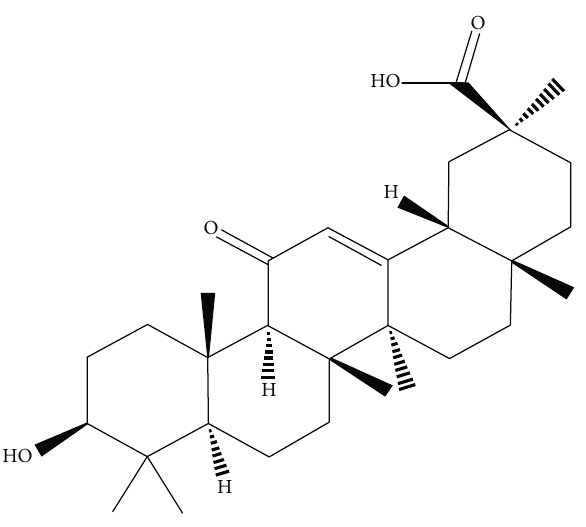
Figure 1: The chemical structure of GA.